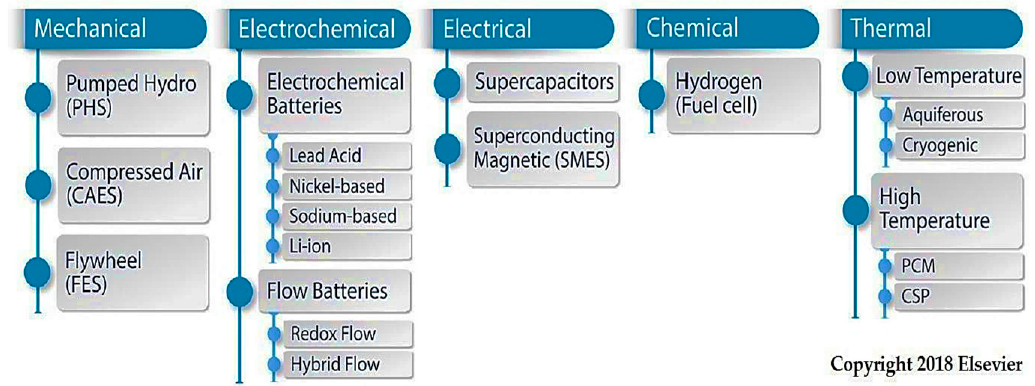
Figure 2. Classification of energy storage technologies by the form of stored energy [39].